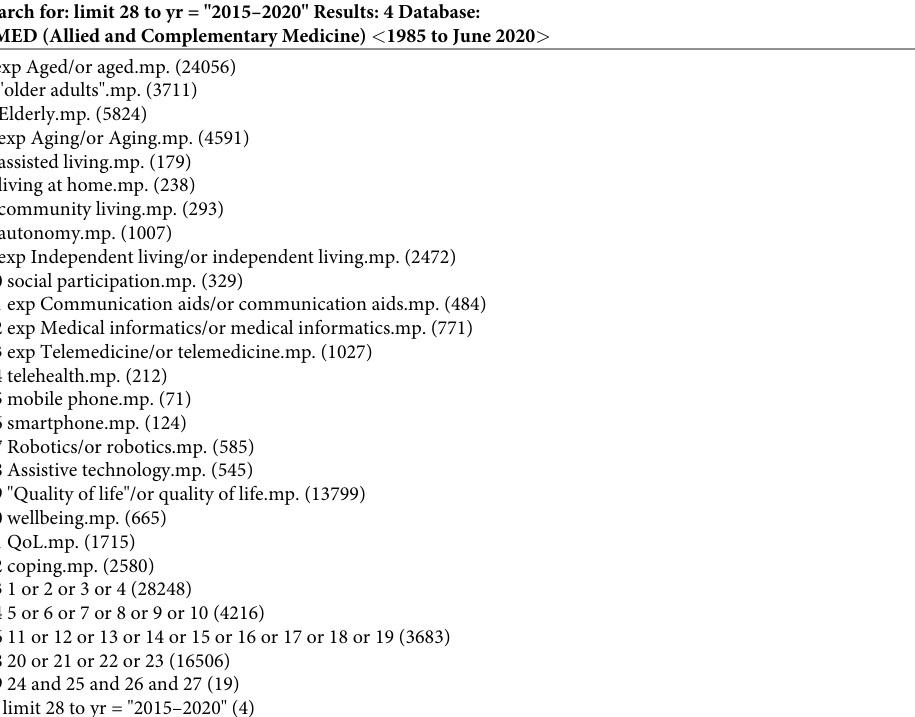
Table 1. Examples of searches in AMED. Search for: limit 28 to yr = "2015–2020" Results: 4 Database: AMED (Allied and Complementary Medicine) < 1985 to June 2020